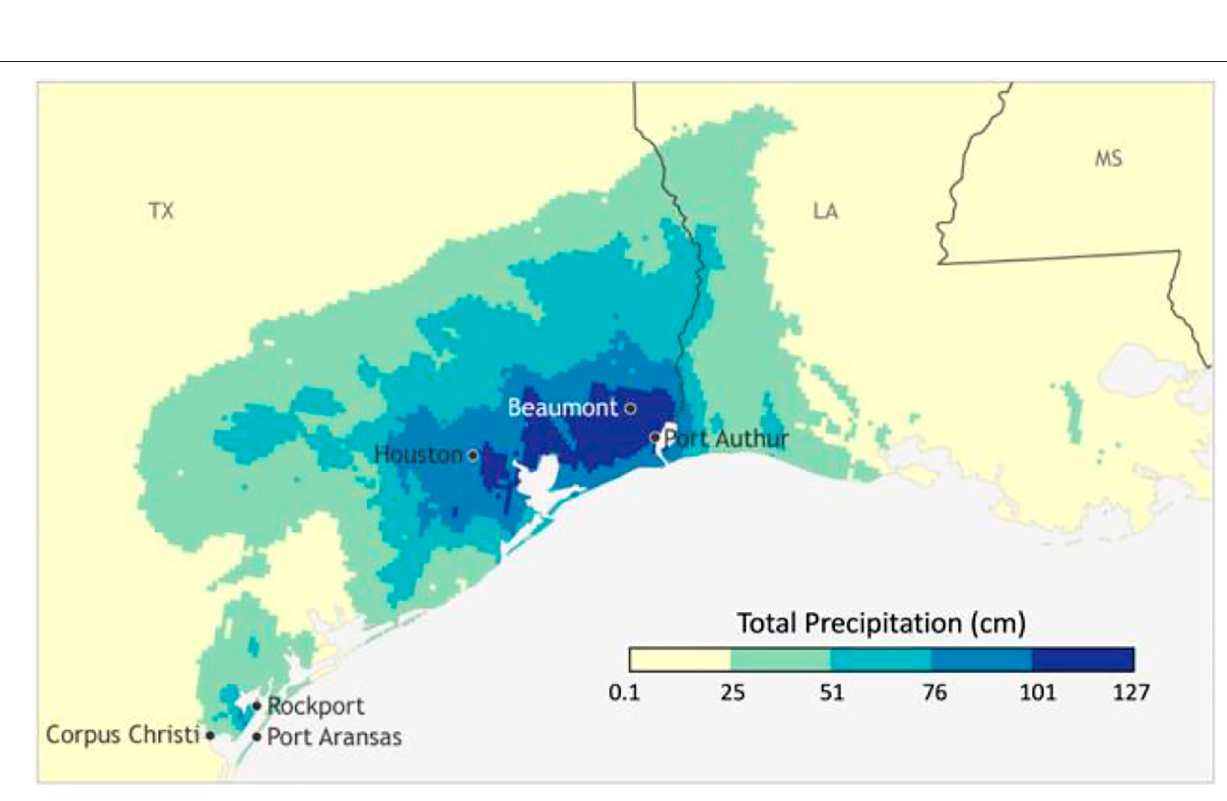
Frontiers in Environmental Science |